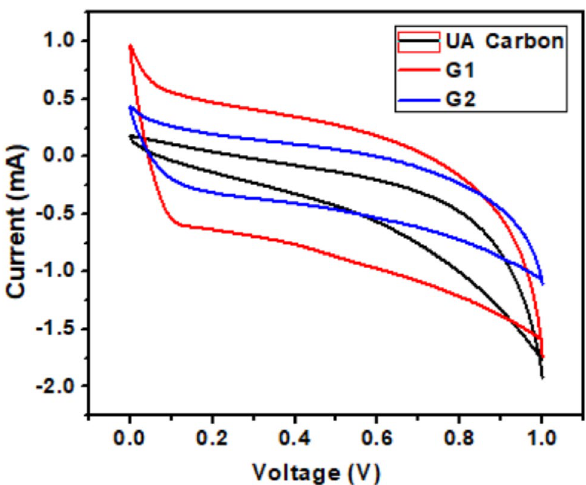
Fig. 8 GCD analysis curve of G1 derived porous